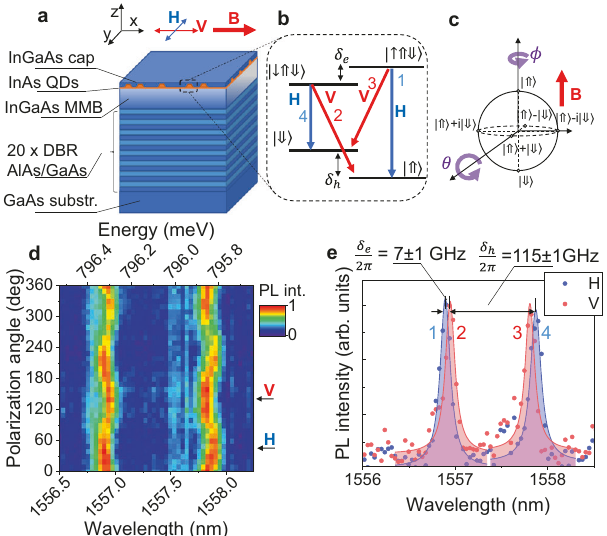
Fig. 1 Quantum-dot spin platform. a Sample layer structure and geometry used (not to scale). A single layer of InAs quantum dots is grown on an InGaAs metamorphic buffer (MMB) layer allowing for emission in the C-band telecom window. Bottom distributed Bragg re fl ectors (DBR, 20 pairs) and air top interface nominally form a 3- λ cavity for increased photon collection ef fi ciency. An external magnetic fi eld (B) is applied along the x -axis (Voigt geometry). Emission collection and excitation is performed along the z -axis. Insets: orientation ( x , y , z ) and polarization convention (H, V) used. b Trion level structure in Voigt magnetic fi eld with radiative transitions selection rules, as used in the experiment. c Bloch sphere representing the spin-qubit. d Color-coded map of the trion photoluminescence spectra as a function of detected polarization angle at 3 T magnetic fi eld in Voigt con fi guration. e Trion photoluminescence spectra at B = 3 T at horizontal (H) and vertical (V) linear